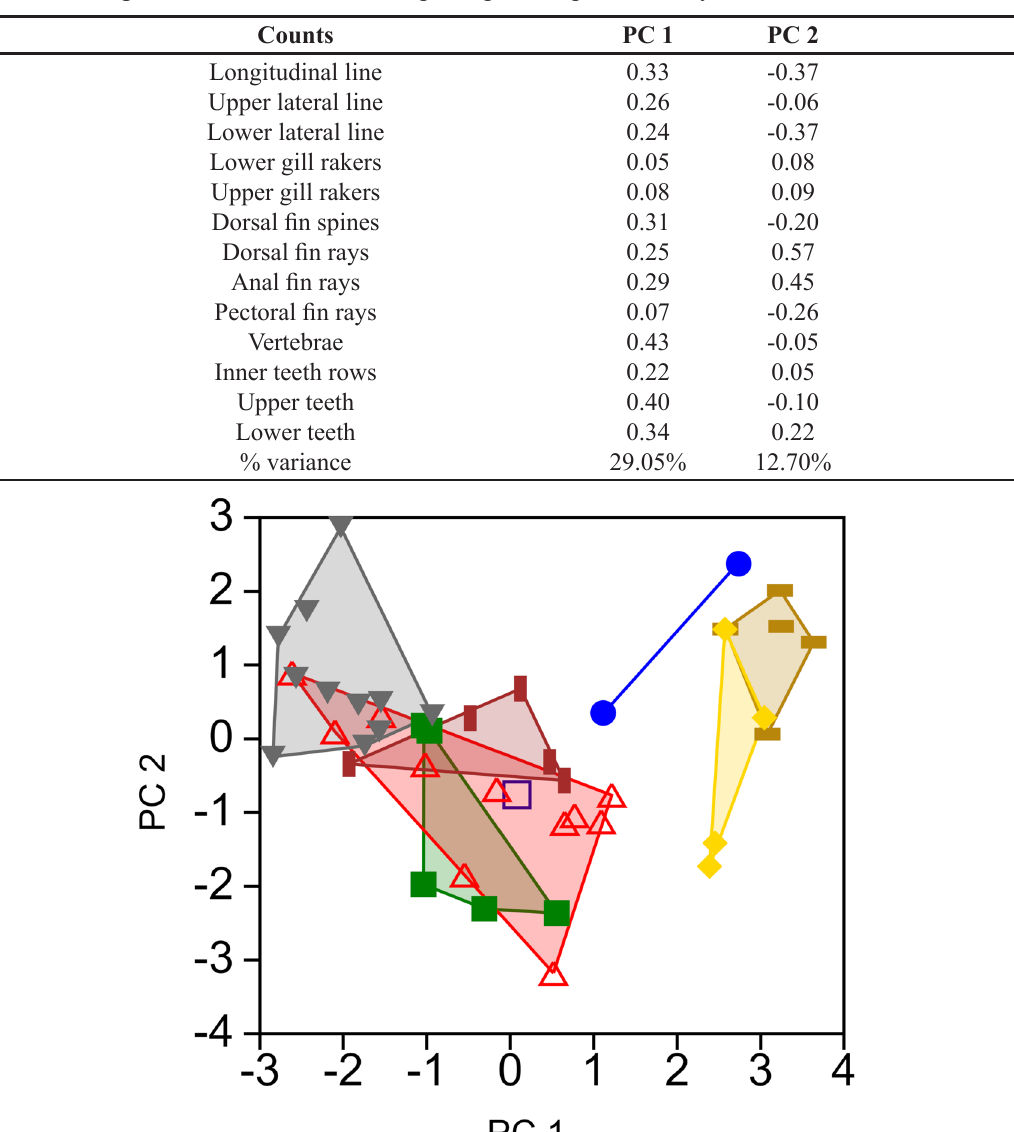
Table 3. Loadings of PC 1 and PC 2 of the principal component analysis of 13 counts.